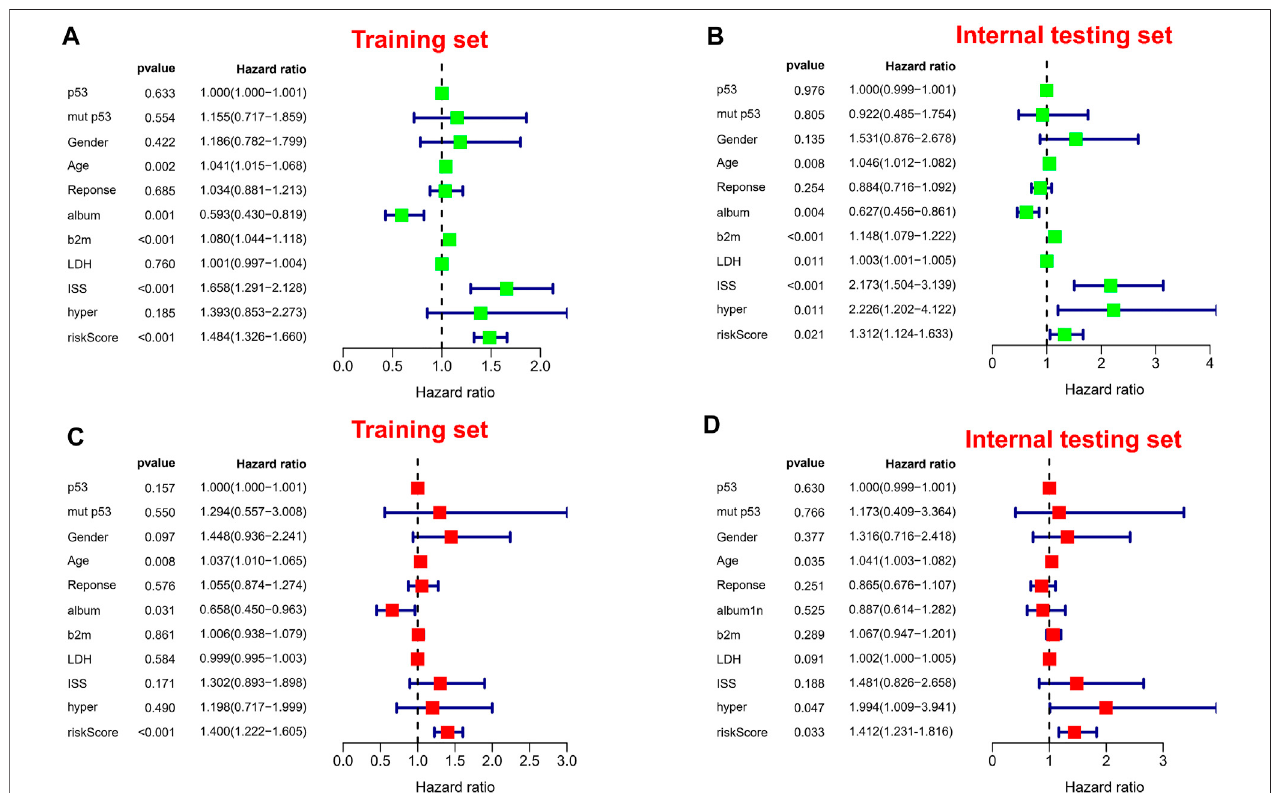
FIGURE 6 | Independent prognostic analysis. (A,B) Forest plots of univariate Cox regression analysis in different sets. (C,D) Forest plots of multivariate Cox regression analysis in different